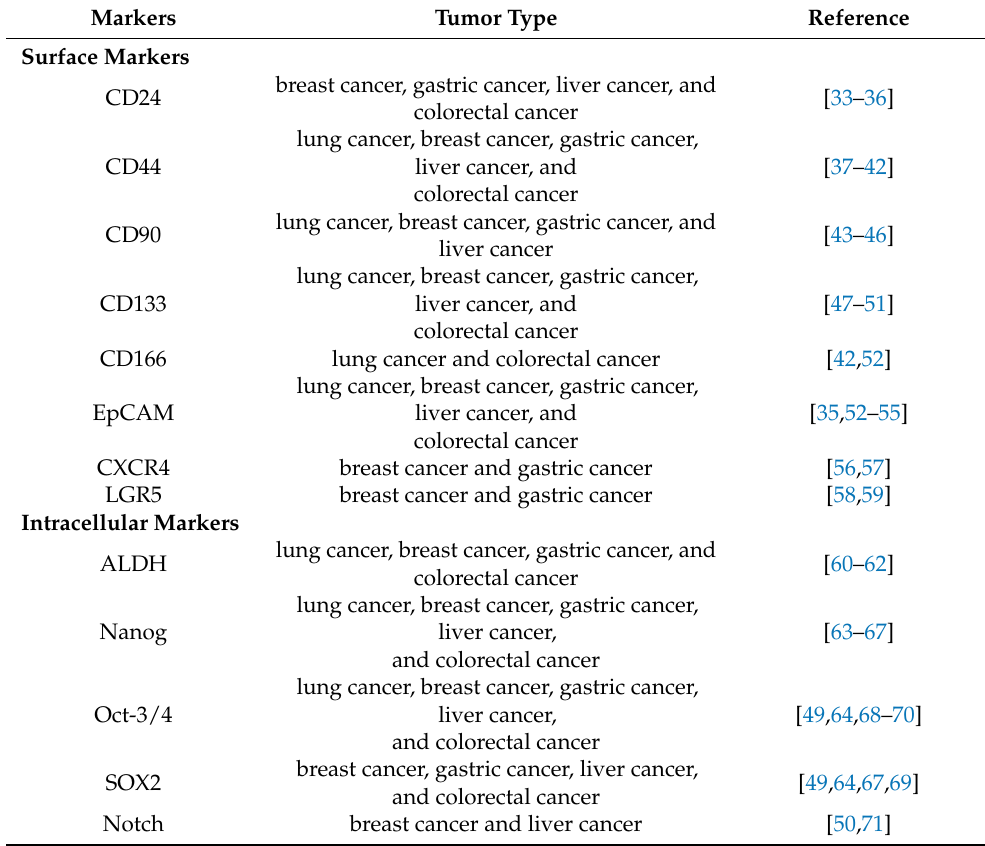
Table 1. Typical biomarkers of cancer stem cells in solid tumors.